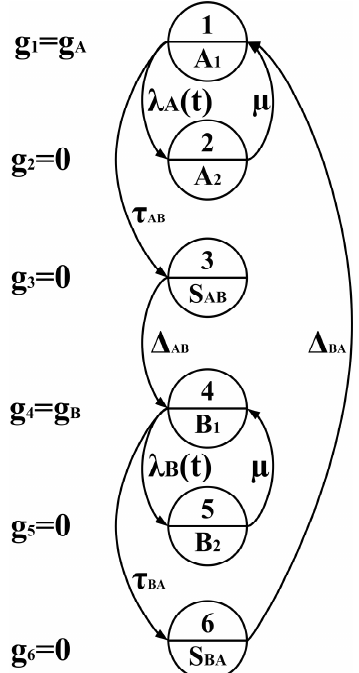
Figure 1. State transition diagram of CNC machine tools A and B.